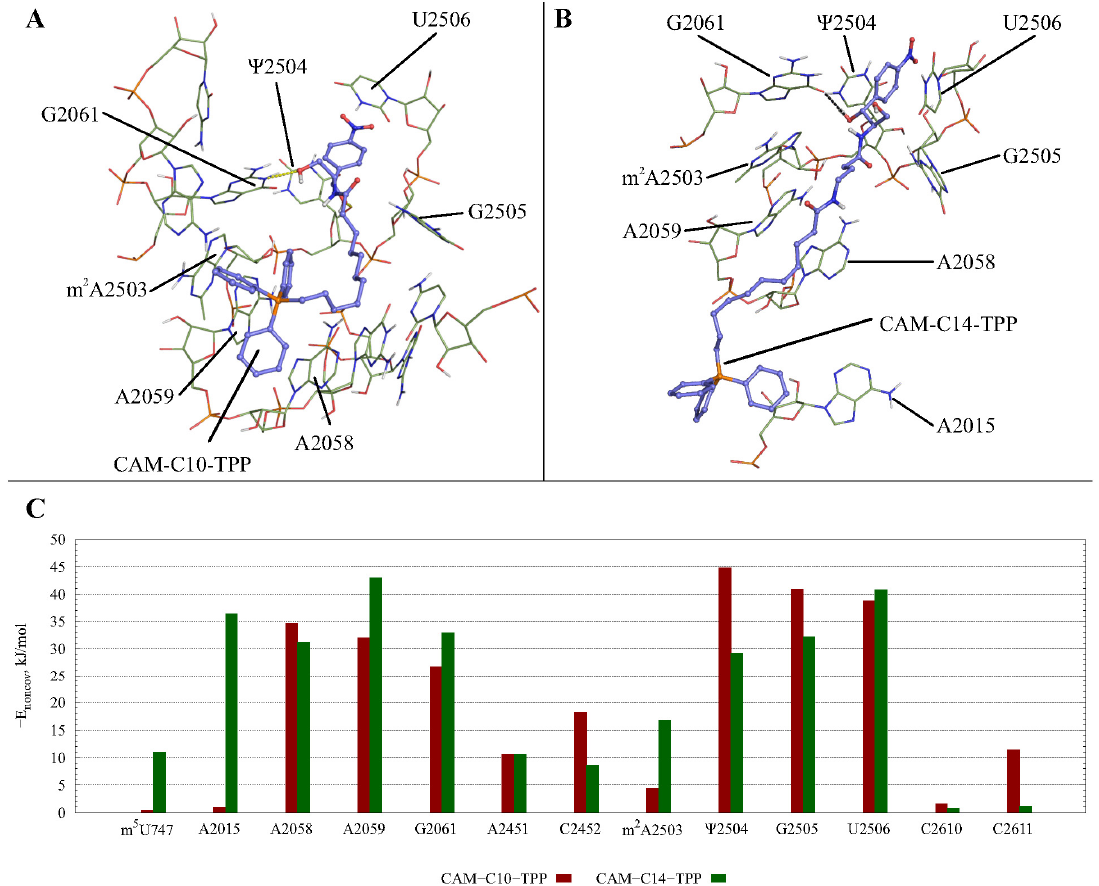
Figure 3. Interactions between CAM-C10-TPP ( A ), CAM-C14-TPP ( B ), and E. coli A,A/P,P–ribosome, obtained using MD simulations. Hydrogen bonds are shown by black dashes. CAM-Cn-TPP nitrophenyl fragment is immersed in the “hydrophobic cavity” formed by the Ψ 2504 and U2506 bases, forming stacking interactions with them. The arrangement of hydrogen bonds for the CAM-C10-TPP complex ( A ) corresponds to the non-canonically linked CHL [59]. For CAM-C14-TPP ( B ), a stable hydrogen bond between the O1-hydroxyl group of the CAM residue and O6 of G2061 is observed. The TPP fragment of CAM-C10-TPP interacts with the “hydrophobic cavity” of the macrolide binding site, forming developed hydrophobic contacts with the A2058, A2059, and C2610 bases. The long C14-linker in CAM-C14-TPP appears in the “hydrophobic cavity” between the A2058 and A2059 bases, and the TPP fragment is located deeper in the NPET adjacent to the residue, A2015. ( C ) The energy of the noncovalent interactions between CAM-C10-TPP (red columns) or CAM-C14-TPP (green columns) and the neighboring 23S rRNA residues of the E. coli ribosome, which are in the canonical A,A/P,P–state. E noncov is shown with a negative sign for improved